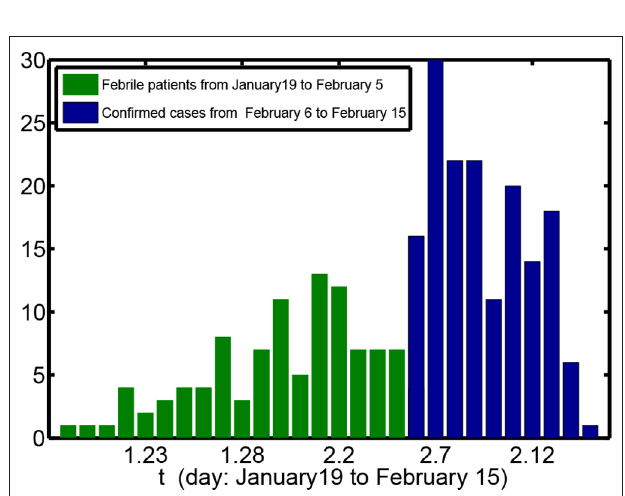
FIGURE 5 | Number of cases plotted against time. The green bars show the number of febrile patients and the blue bars the number of confirmed COVID-19 cases with reported onset